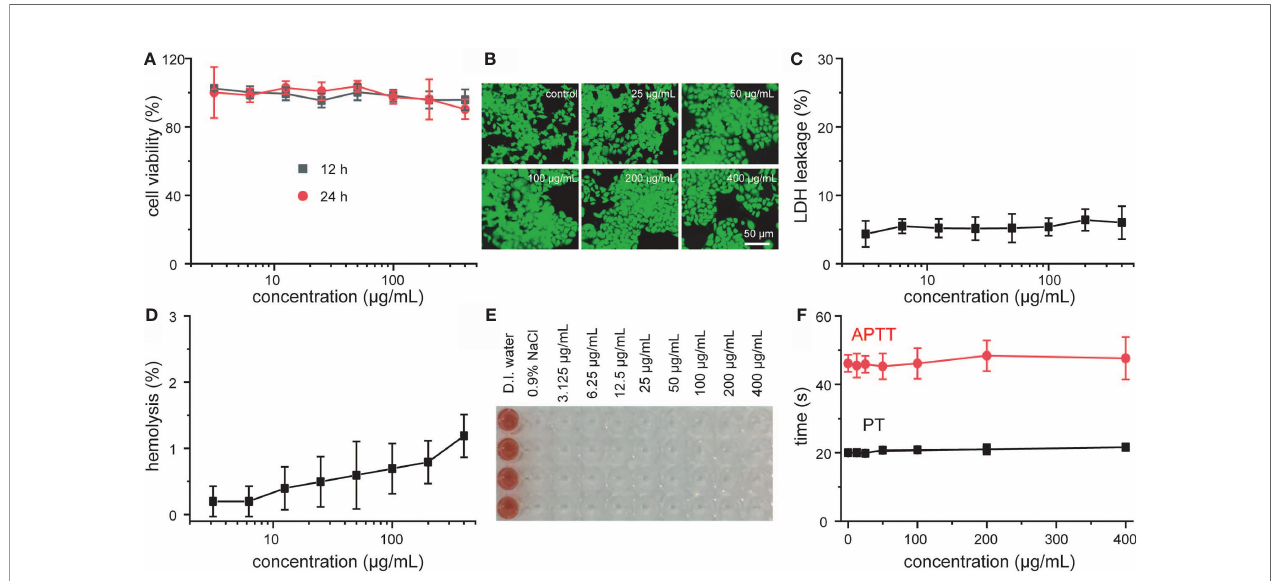
FIGURE 3 | Viability (A) , live-dead staining images (B) , and LDH leakage (C) of 4T1 cells treated with MNCs. Hemolysis assay (D) , photo of hemolysis (E) , and blood coagulation assay (F) after co-incubation with